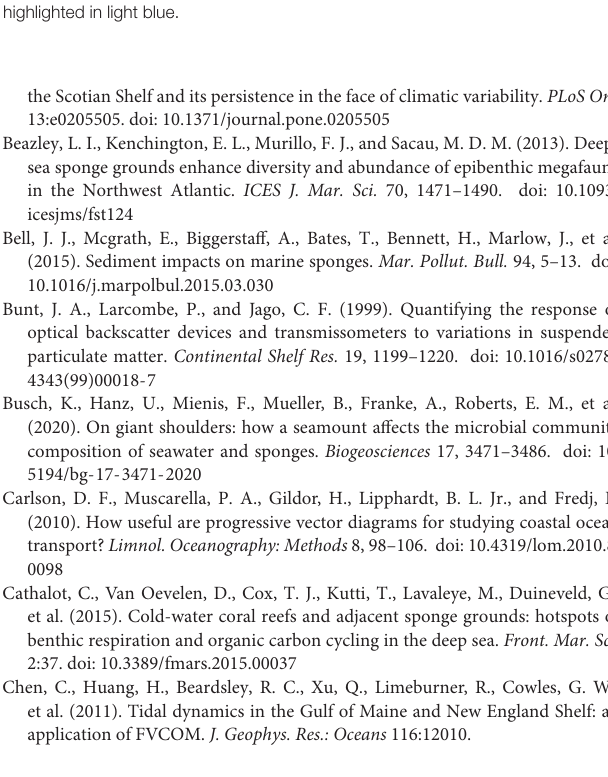
Supplementary Figure 1 | Pearsons correlations between long-term record data. Supplementary Figure 2 | u and v components of the current and wind data with the daily moving average shown by thick lines. Main storm events are highlighted in light